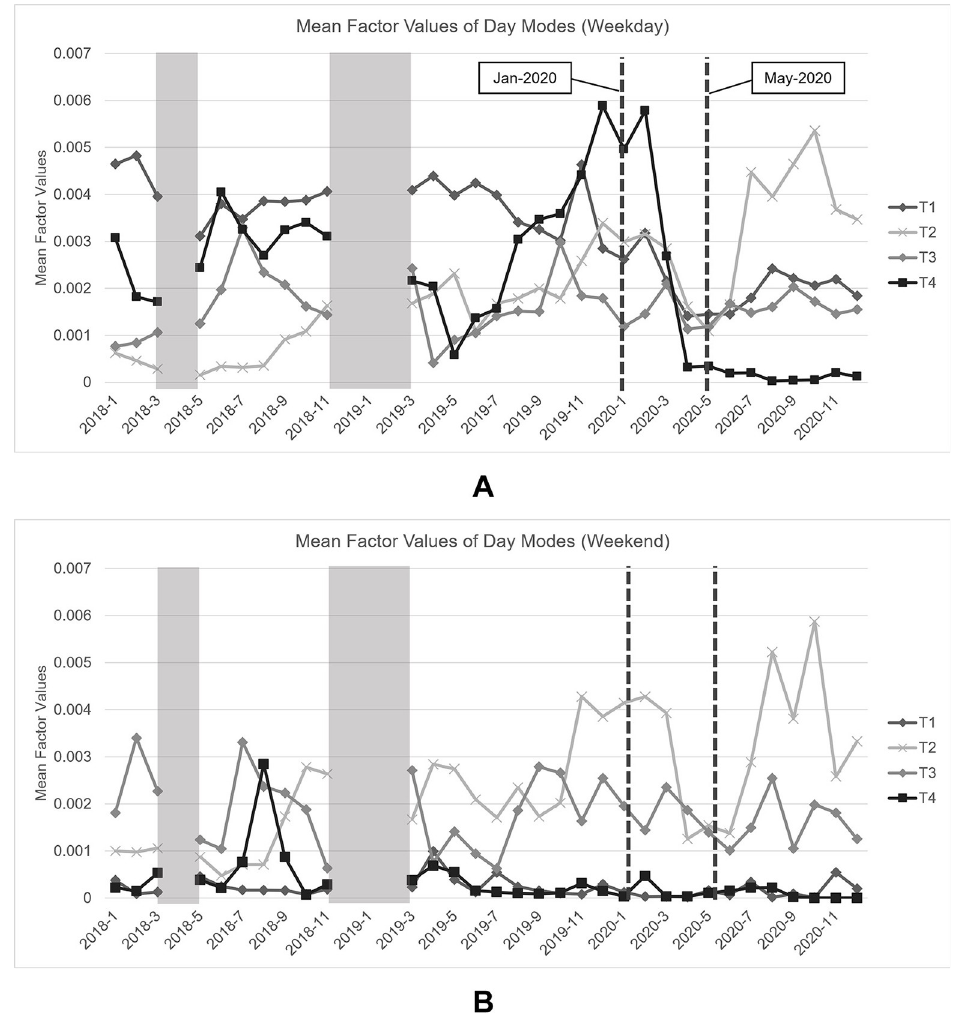
Fig 12. Monthly mean factor values of day mode. (A) Weekdays, and (B) weekends.